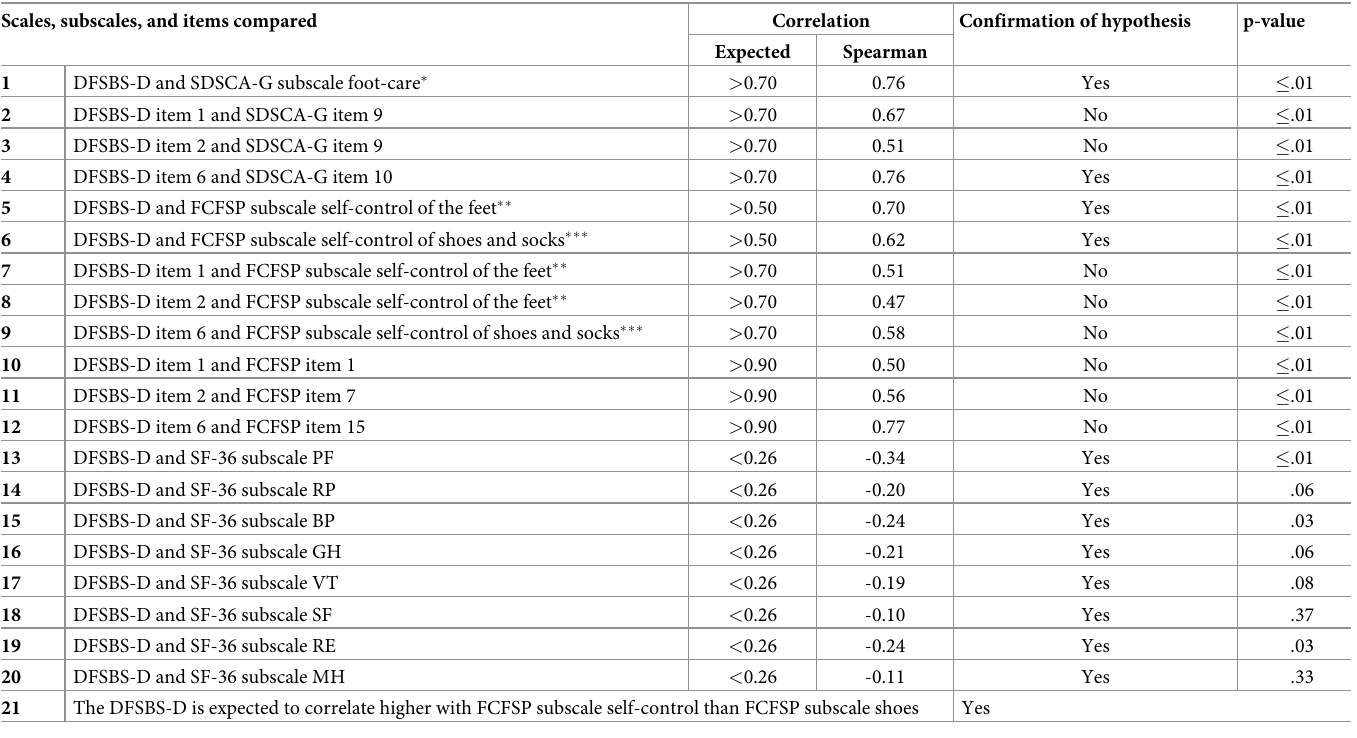
Table 3. Predefined hypotheses and Spearman correlation coefficients. Scales, subscales, and items compared